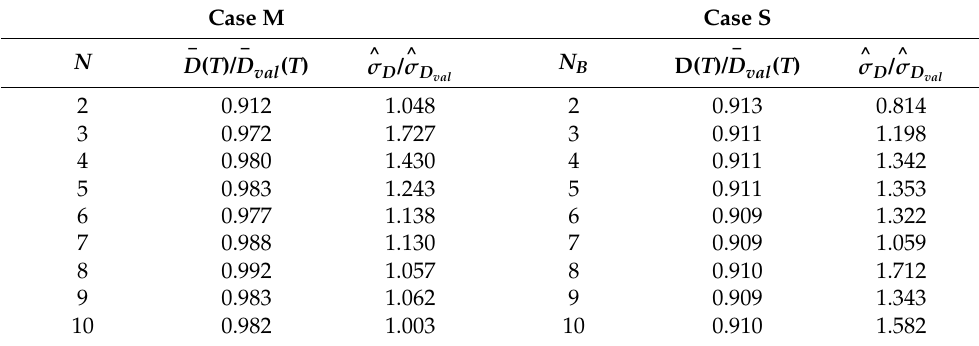
Table 3. Statistics of fatigue damage calculated from measured stationary load